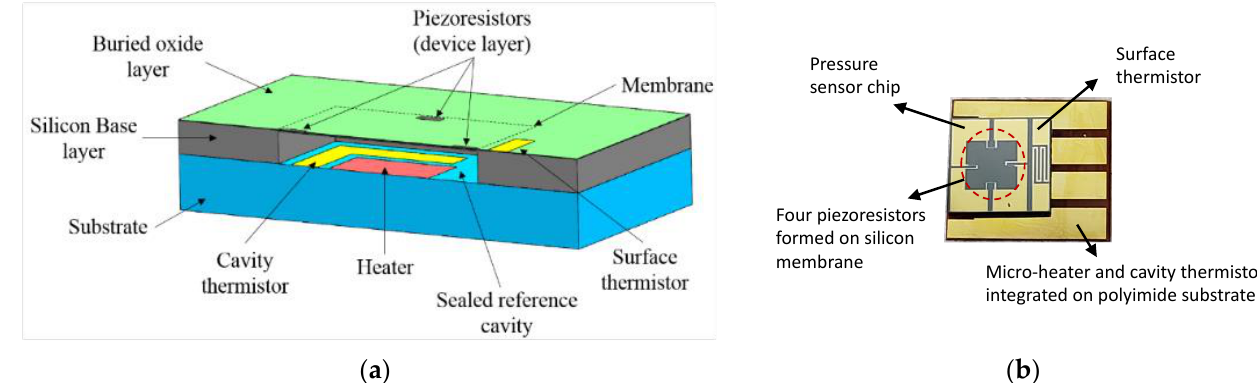
Figure 4. Photo of a prototype flexible two-phase, self-calibrating pressure sensor.